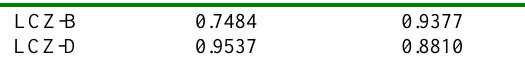
Table 2 . Correlation between LST and AT per LCZ describing stations.